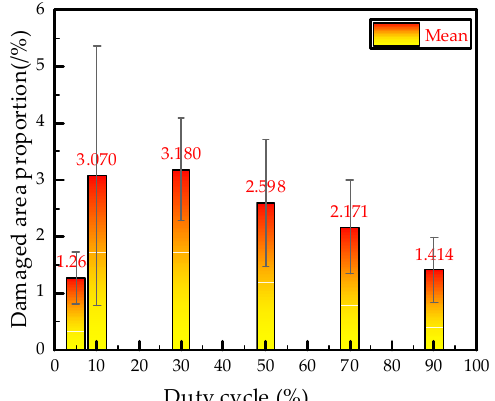
Figure 7. Damaged area proportion of electrical tree versus duty cycle under square wave voltage at 30